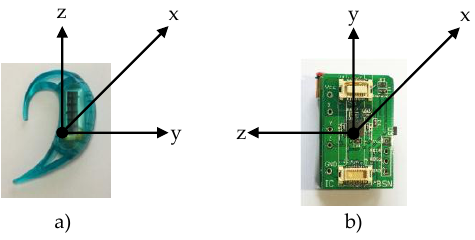
Figure 2. An ear-worn activity recognition (e-AR) sensor ( a ) and a Body Sensor Network (BSN) node ( b ) along with their coordinate systems.